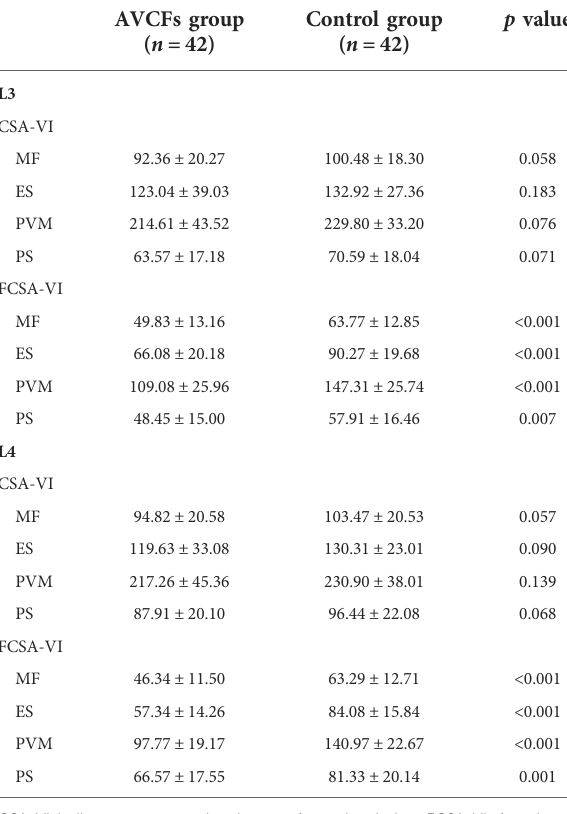
CSA-VI indicates cross-sectional area of vertebra index; FCSA-VI, functional cross-sectional area of vertebra index; MF, multi fi dus; ES, erector spinae; PVM, paravertebral muscle; PS, psoas.